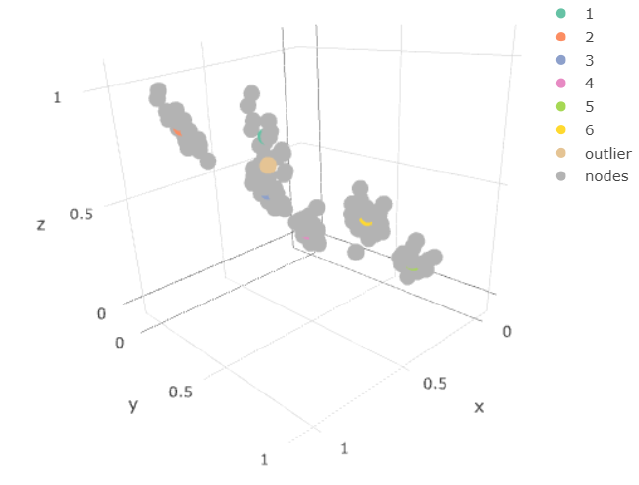
Figure 8. 1-layer Final SOMs for the original spaces.